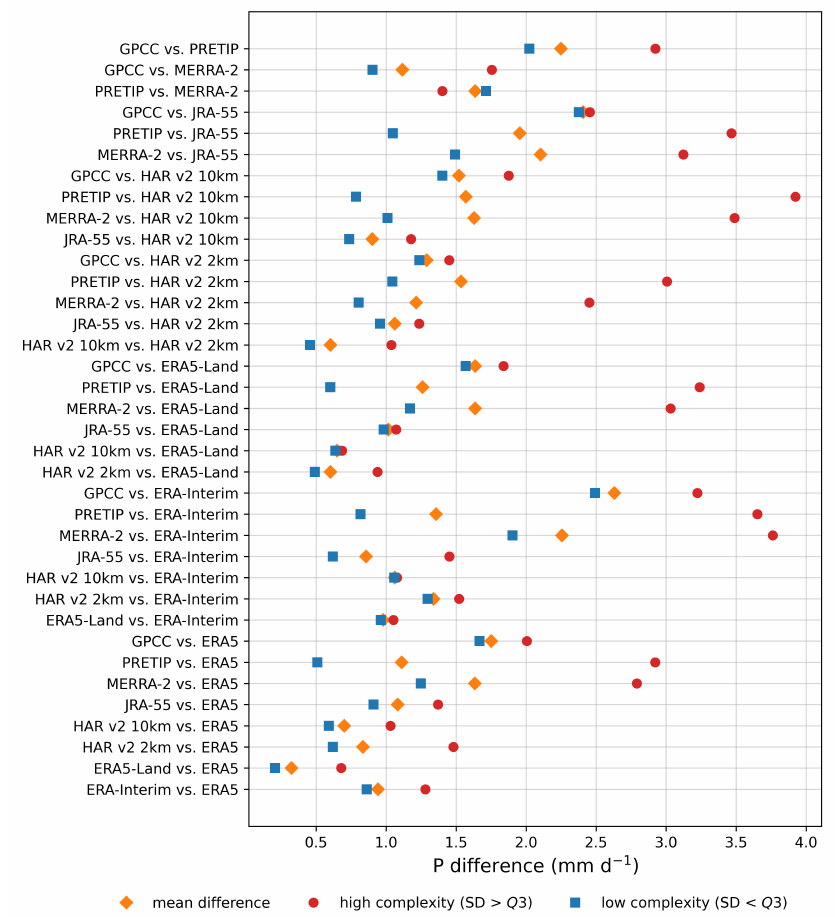
Figure 7. Absolute precipitation difference (mmday − 1 ) based on terrain complexity aligned with the coarsest grid (GPCC). Complexity is described as high (SD > Q3) or low (SD ≤ Q3) standard deviation of ALOS-DEM elevation within a single grid cell of the common grid. Blue rectangles represent low terrain complexity, red dots indicate high terrain complexity and the yellow diamonds depict the mean